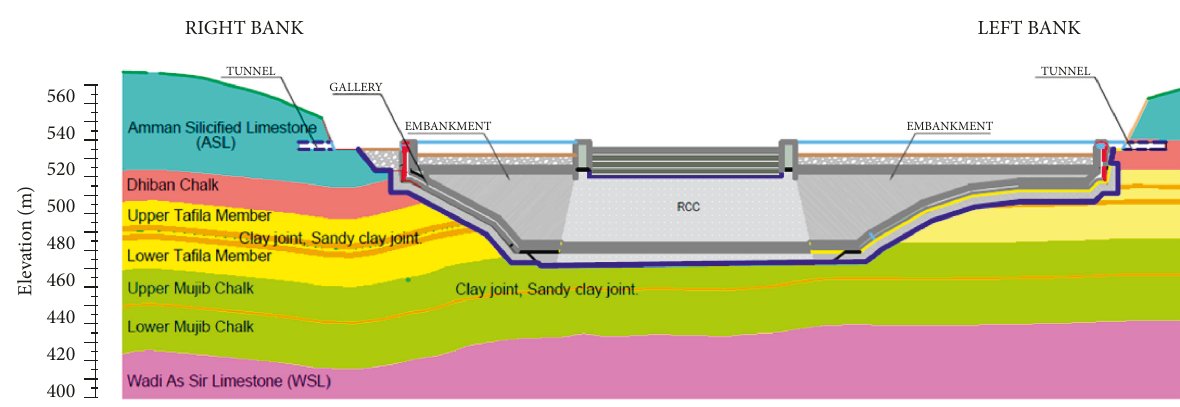
Figure 4: Geological cross-section of Wala dam site. Table 1: Material soil properties of dam foundation and earthfill embankment.